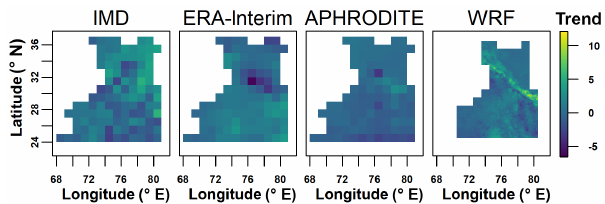
Figure 7. Trend (mmmonth − 1 year − 1 ) of summer precipitation.